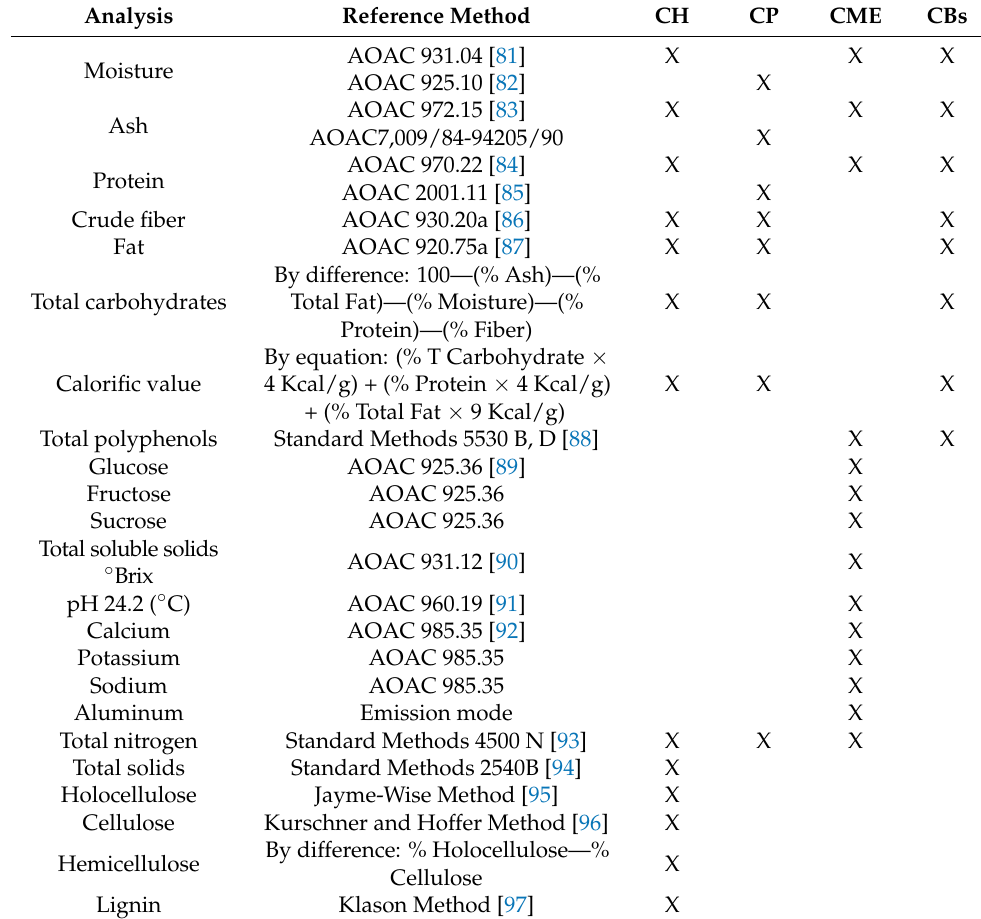
Table 8. Chemical characterization of the various cacao fruit